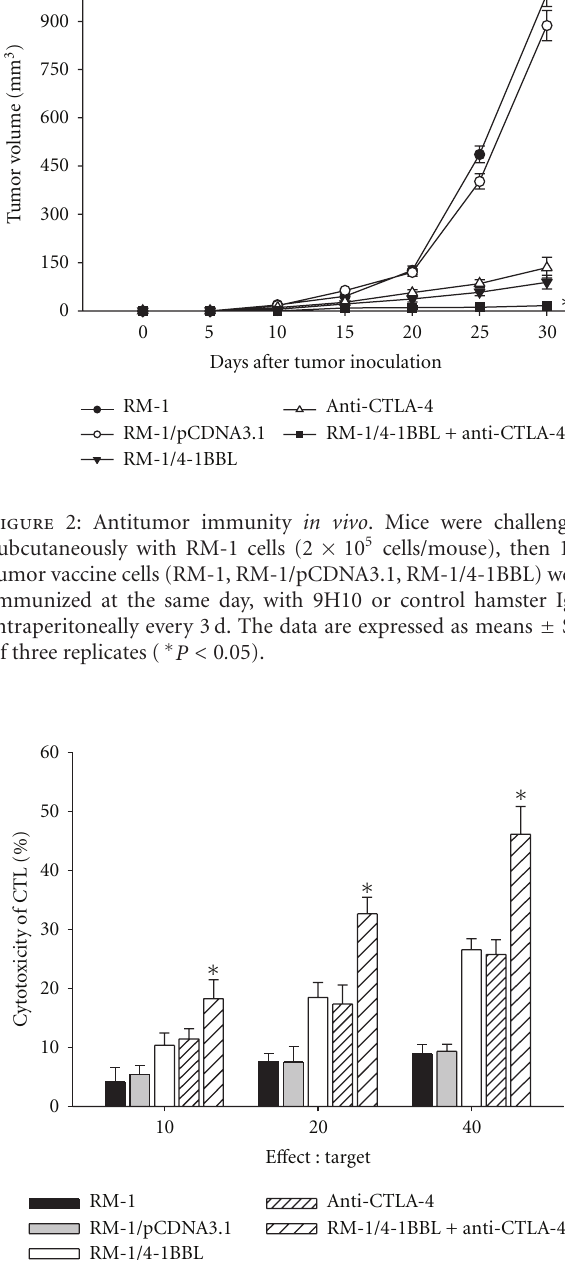
Figure 3: Cytotoxicity assay. Spleens were harvested from mice rejecting RM-1 cells and restimulated in vitro with MMC-treated RM-1 cells. 7d later, cells were collected and purified by Ficoll- Histopaque gradient centrifugation as e ff ector cells for detecting specific cytotoxicity against target cells. The data are expressed as means ± SD of three replicates ( ∗ P < 0 .